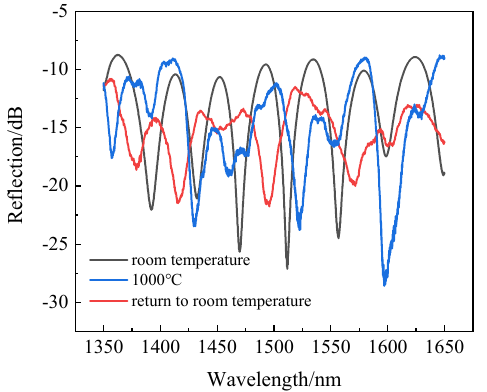
Figure 9. Changes in the spectra as the room temperature increased to 1000 °C.